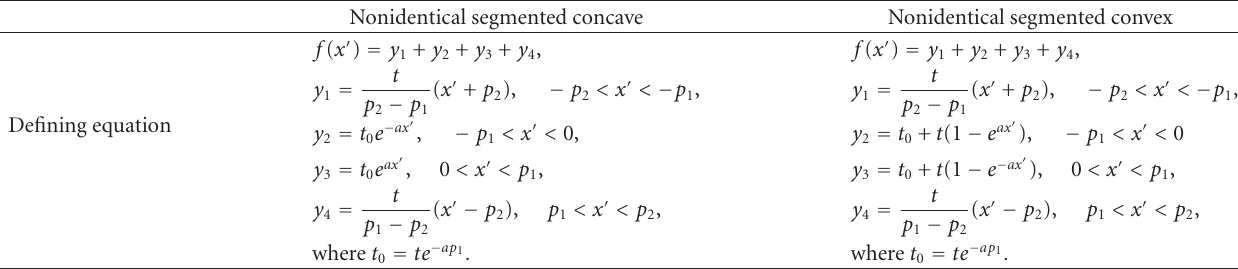
Table 1: Nonidentical exponential serration functions.